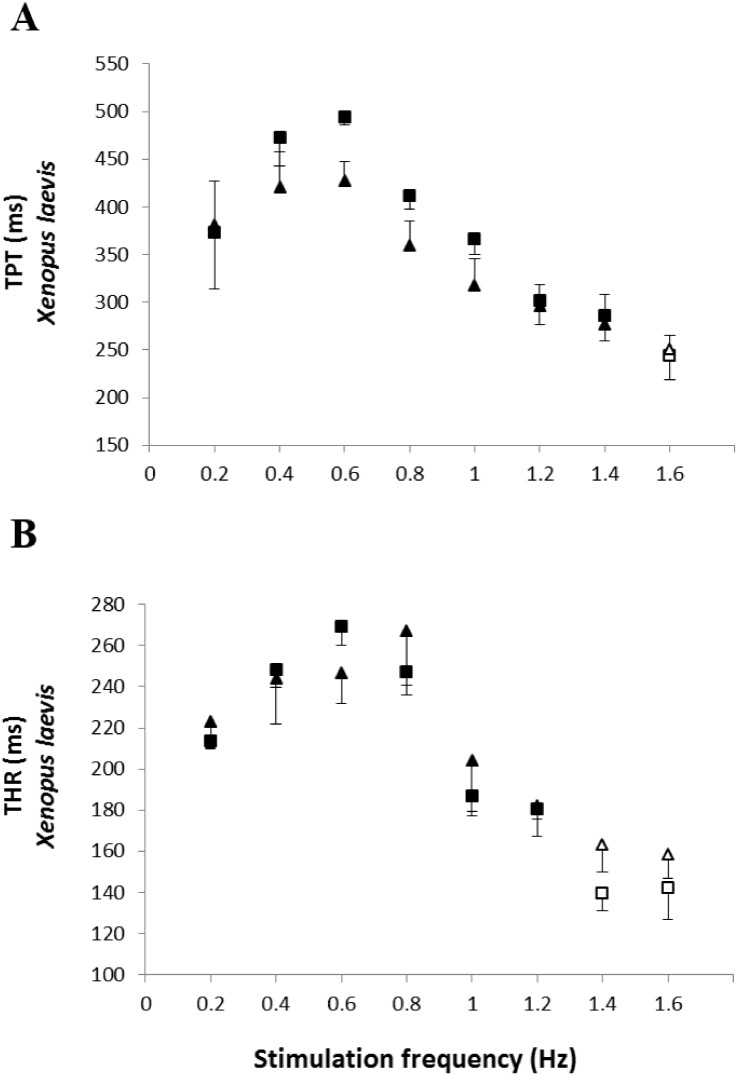
Time to peak tention and relaxation of heart strips os control and infected X. laevis.Effect of increased stimulation frequency over time to reach the peak tension (A: TPT - ms) and the time to reach 50% of relaxation (B: THR - ms) of the ventricular strips of X. laevis (squares represent Bd− group - n = 8, and triangles represent Bd+ group - n = 9). The points represent the mean values ± S.E. White markers denote significant difference (Tukey-Kramer test - P < 0.05) between the TPT or THR developed by the same species at each stimulation frequency in relation to the initial frequency (0.2 Hz). There were no significant differences (Dunnett’s test - P > 0.05) between different treatments (Bd− and Bd+) TPT and THR.